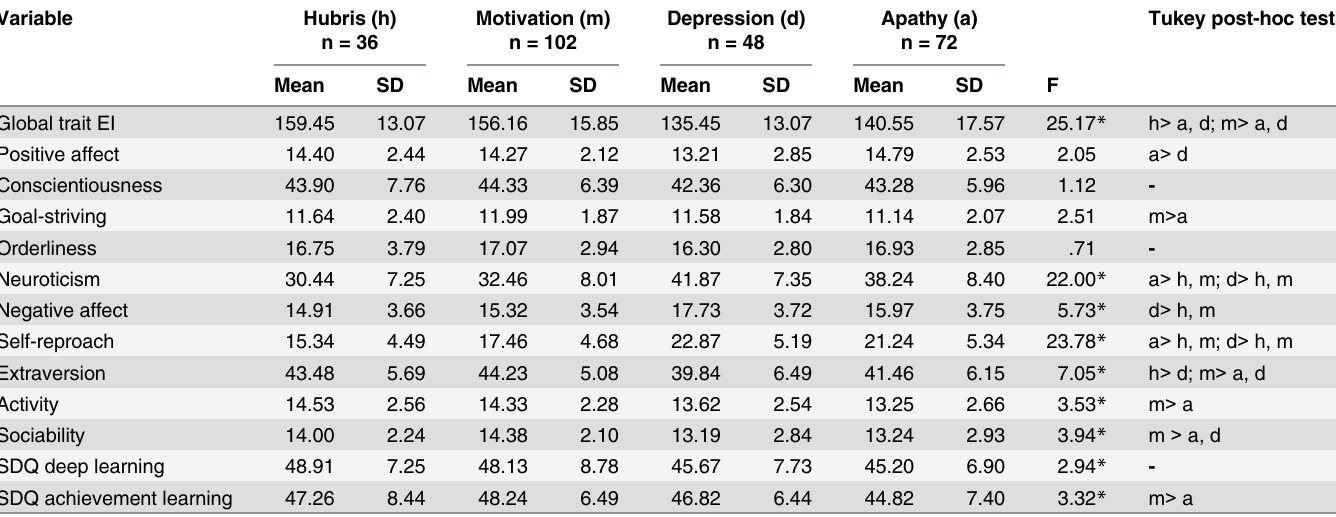
Table 5. Descriptive Statistics and One-Way ANOVA Results for the Global Classification.